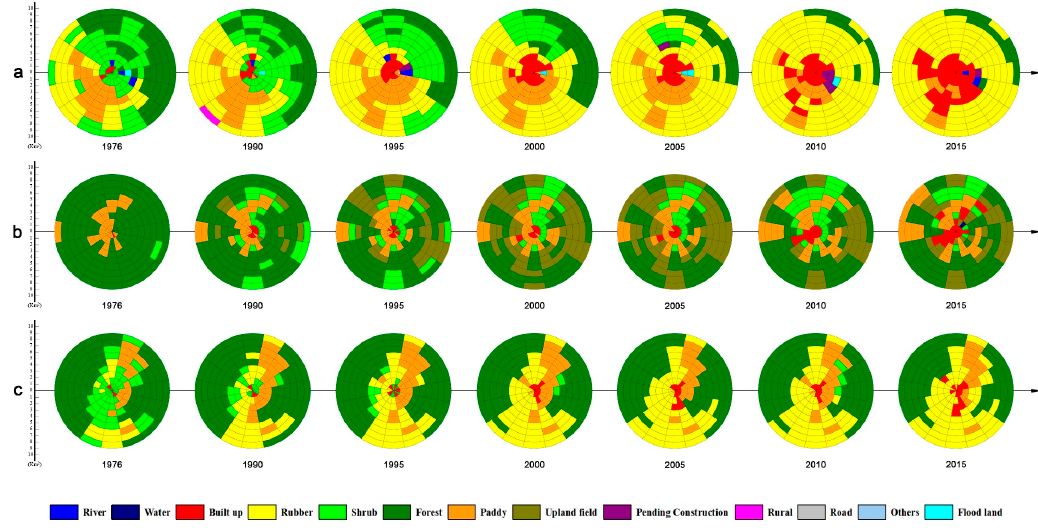
Figure 5. Dynamics of the land use pattern outside of built up areas. ( a ) Dynamics of the land use pattern outside the city proper within an area with a 10-km radius; ( b ) dynamics of the land use pattern outside the county town of Menghai within an area of a 9-km radius; ( c ) dynamics of the land use pattern outside the county town of Mengla within an area of a 9-km radius.